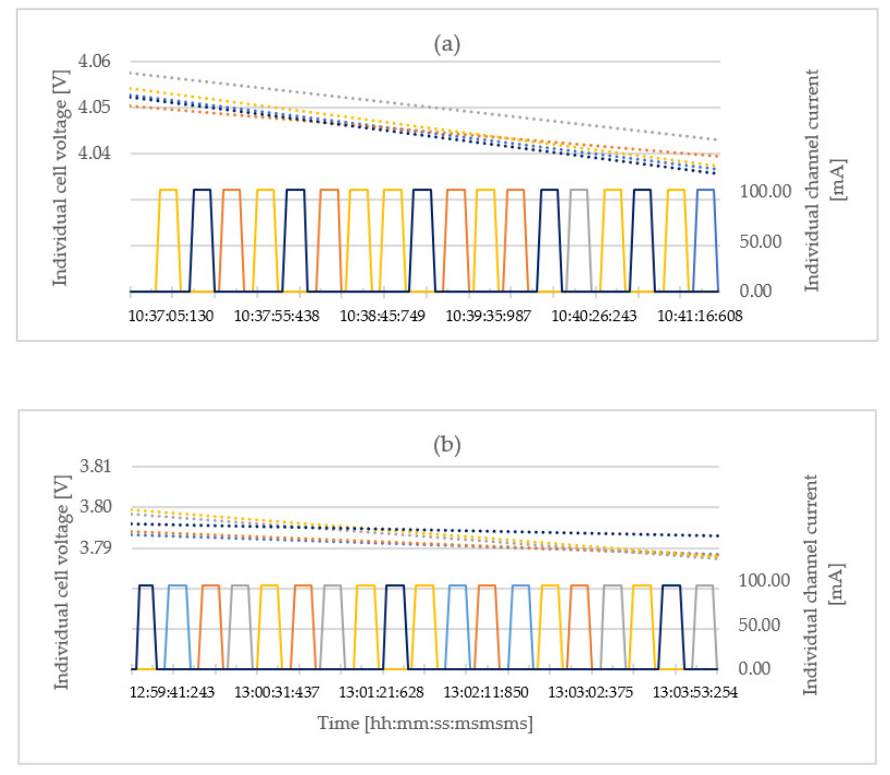
Figure 18. Initial ( a ) and final ( b ) battery-cell voltage (trendlines) and balancing channels current oscillograms in the permanent storage system configuration. Table 3. Balance system configuration data.